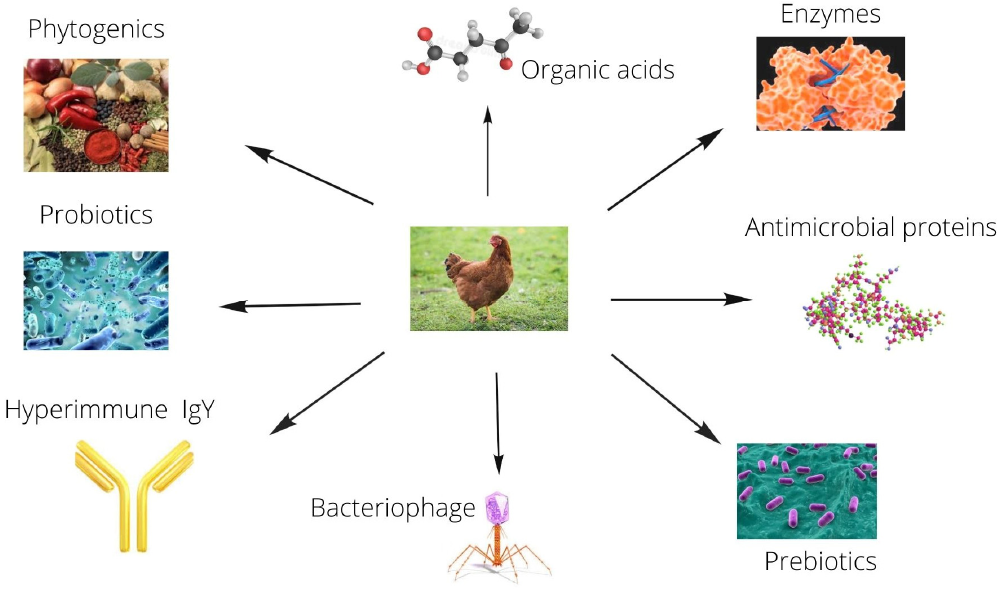
Figure 1. Different feed additives reported in poultry production.